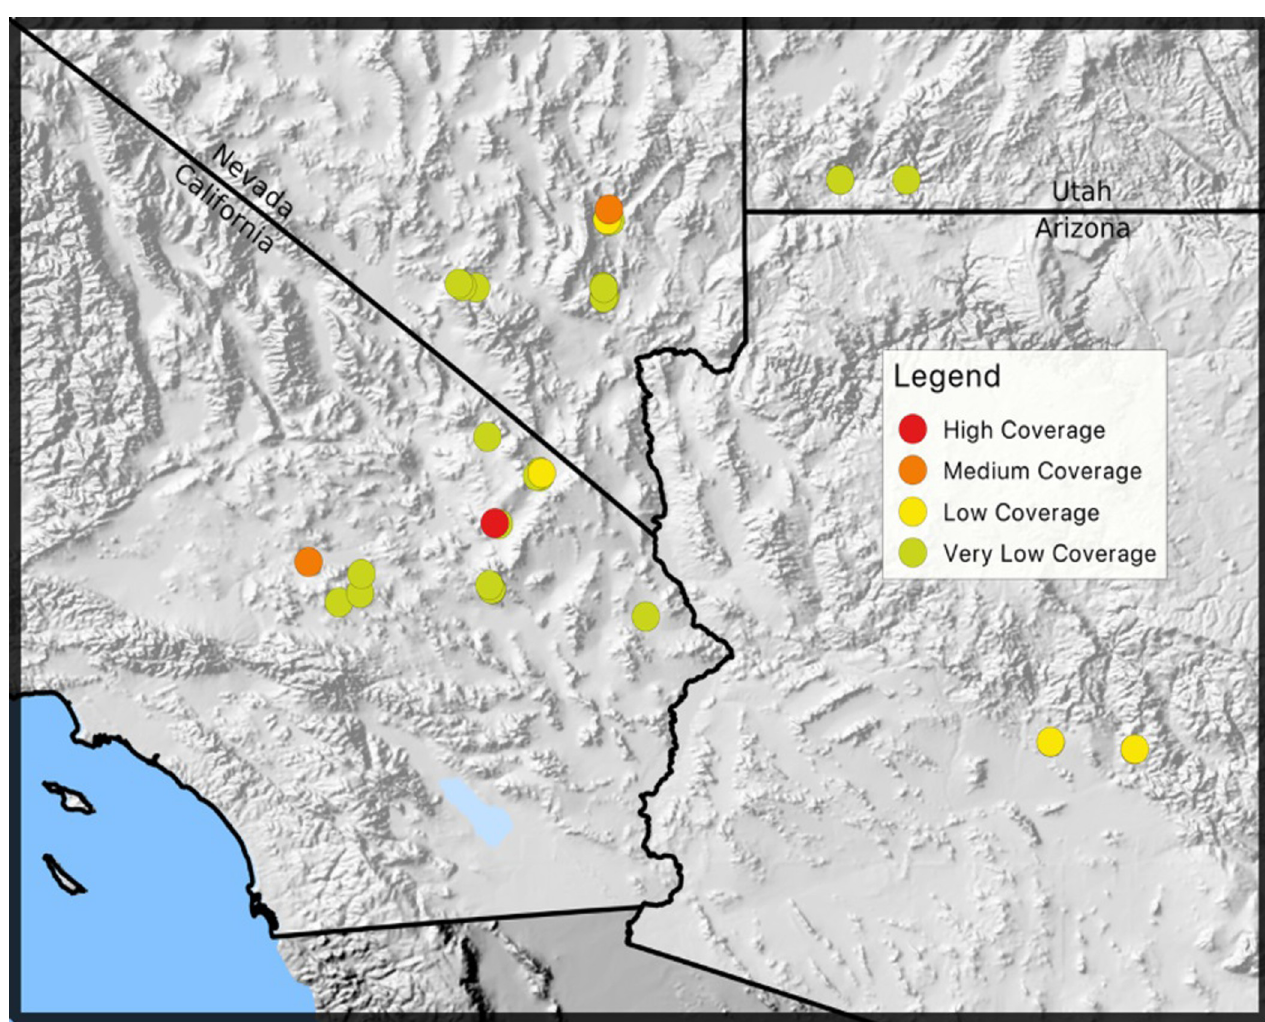
Fig 1. Locations in the Mojave and Sonoran Deserts where Mycoplasma spp. isolates were collected. Locations are color-coded based on genome coverage from next-generation sequencing: high ( > 40x), medium ( > 25x), low ( > 2x), and very low ( < 2x). The map was created with data from the USGS National Map